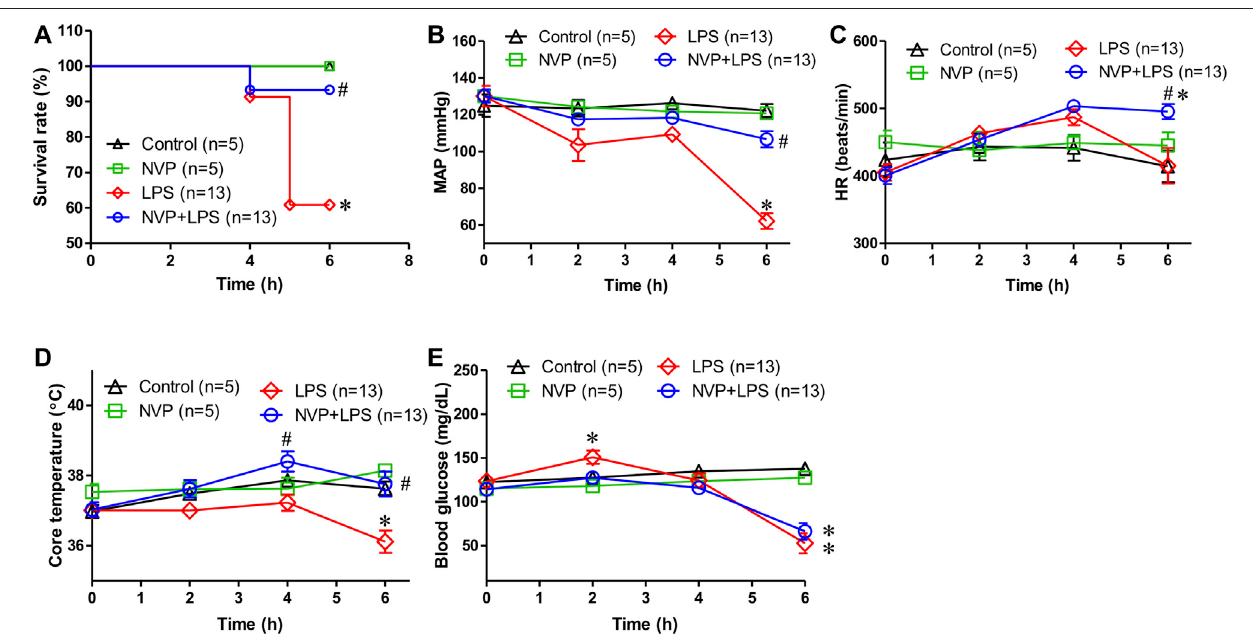
FIGURE1| EffectsofNVP-AUY922 onphysiological parameters. (A) Survivalrate. Effects ofNVP-AUY922pre-treatmenton survivalrate during endotoxemia. (B) Meanarterialpressure.EffectsofNVP-AUY922pre-treatmentonmeanarterialpressureduringendotoxmia.MAP:meanarterialbloodpressure. (C) Heartrate.Effectsof NVP-AUY922 pre-treatment on heart rate during endotoxmia. HR: heart rate. (D) Bodytemperature. Effects ofNVP-AUY922 pre-treatment on core temperature during endotoxmia. (E) Blood glucose. Effects of NVP-AUY922 pre-treatment on blood glucose during endotoxmia. NVP: NVP-AUY922 5 mg/kg. Values are expressed as mean ± SEM. * p < 0.05 vs. Control group, # p < 0.05 vs. LPS